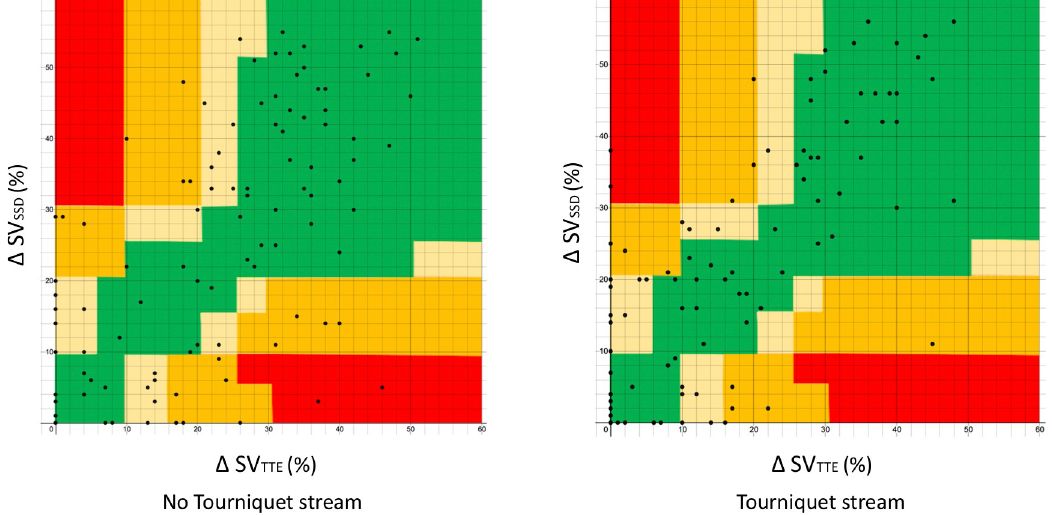
Fig 7. Error grid showing changes in stroke volume from baseline ( Δ SV) recorded using suprasternal Doppler (SSD) and trans-thoracic echocardiography (TTE). Coloured zones represent the perceived degree of clinical harm resulting from a measurement error: Green = none, Yellow = mild, Orange = moderate, Red =